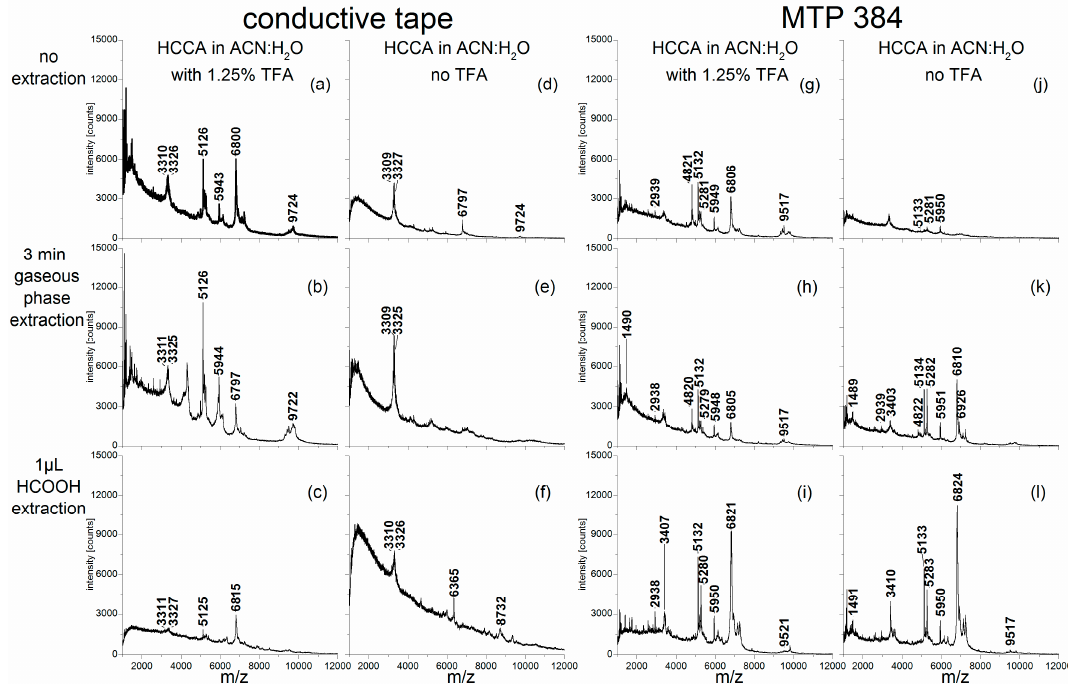
Figure A1. Averaged MALDI-TOF mass spectra ( n = 5) of Betula tatewakiana pollen grains: measured on conductive tape with TFA in the matrix solution ( a – c ), on conductive tape without TFA in the matrix solution ( d – f ), on the steel target (MTP 384) with TFA in the matrix solution ( g – i ) and on the steel target without TFA in the matrix solution ( j – l ) (in the rows: extraction procedure).